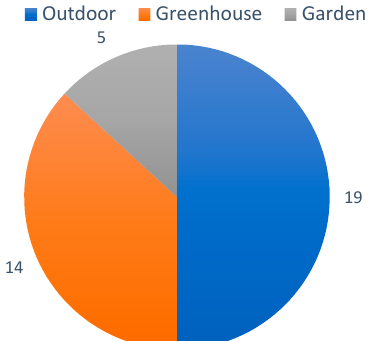
Figure 4. Number of papers that proposed irrigation systems for different sorts of agriculture.